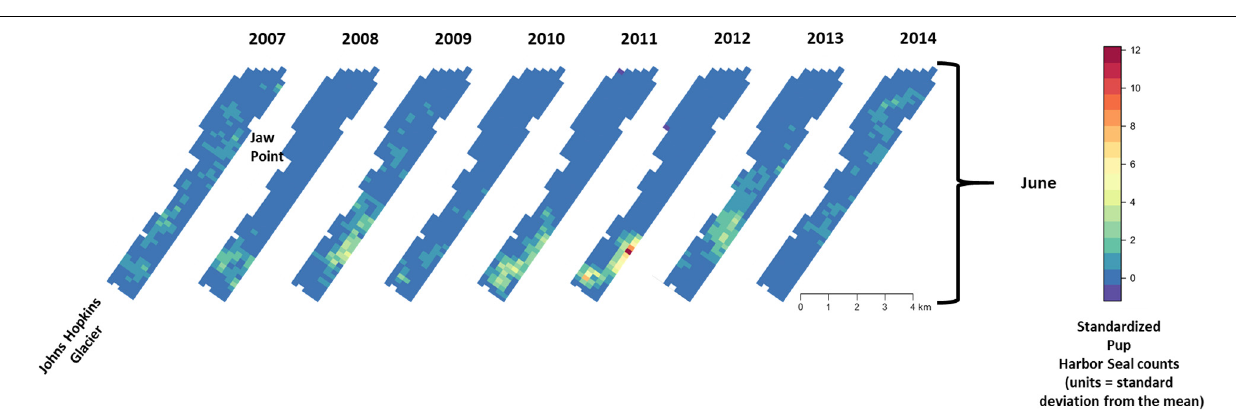
FIGURE 8 | Median of posterior distribution of expected value of z-standardized pup harbor seal counts in Johns Hopkins Inlet during the pupping period in June from 2007 to 2014. Grid cell size is 200 m × 300